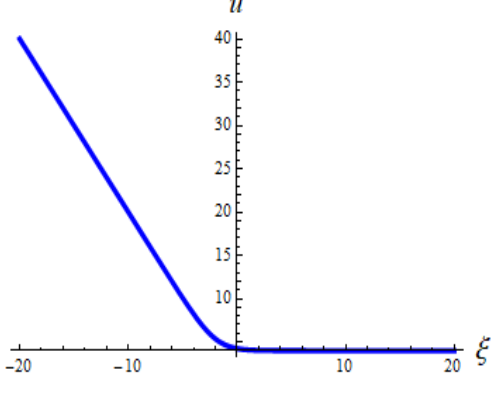
Figure 1: (a) 2D plot for u 2 . (b) 3D plot for u 2 ( x , y ) , when t = 0 .